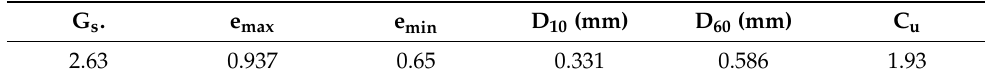
( b ) Figure 3. Schematic diagram of model: ( a ) Plan view; ( b ) Front view. Table 1. Properties of Jumunjin standard sand. 𝐆 𝐬 .